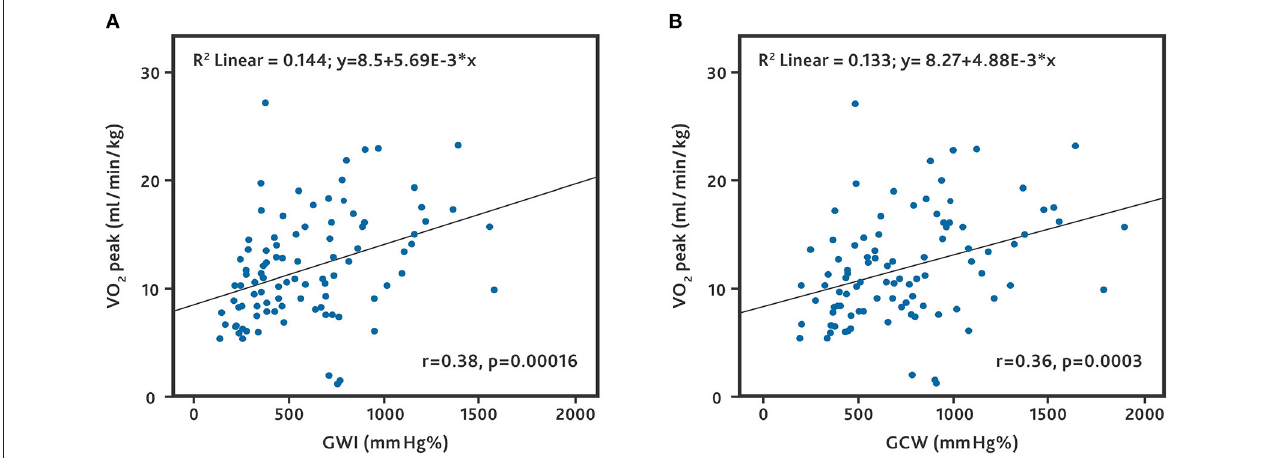
FIGURE 1 | Correlation between peak oxygen uptake and global work parameters. All patients who underwent cardiopulmonary exercise testing. (A) Correlation between peak oxygen uptake (VO 2 peak) and global work index (GWI). (B) Correlation between VO 2 peak and global constructive work (GCW).